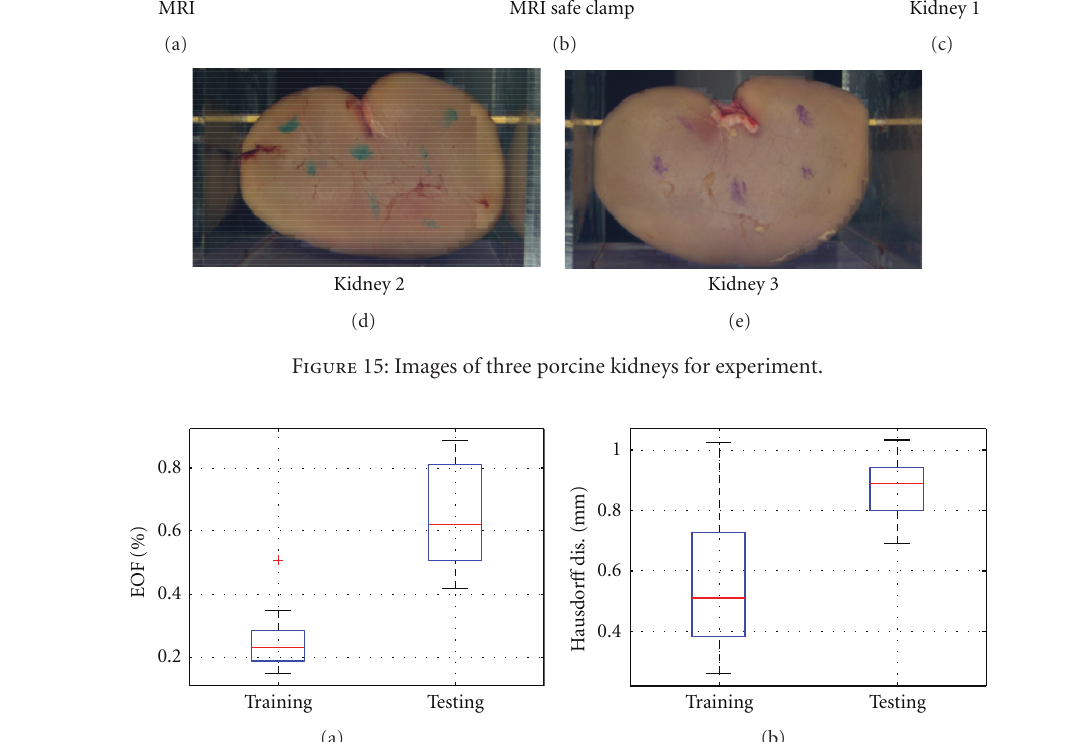
Figure 16: Boxplots of representation error in intramodel experiment: (a) EOF of training and testing set, (b) Hausdor ff distance of training and testing